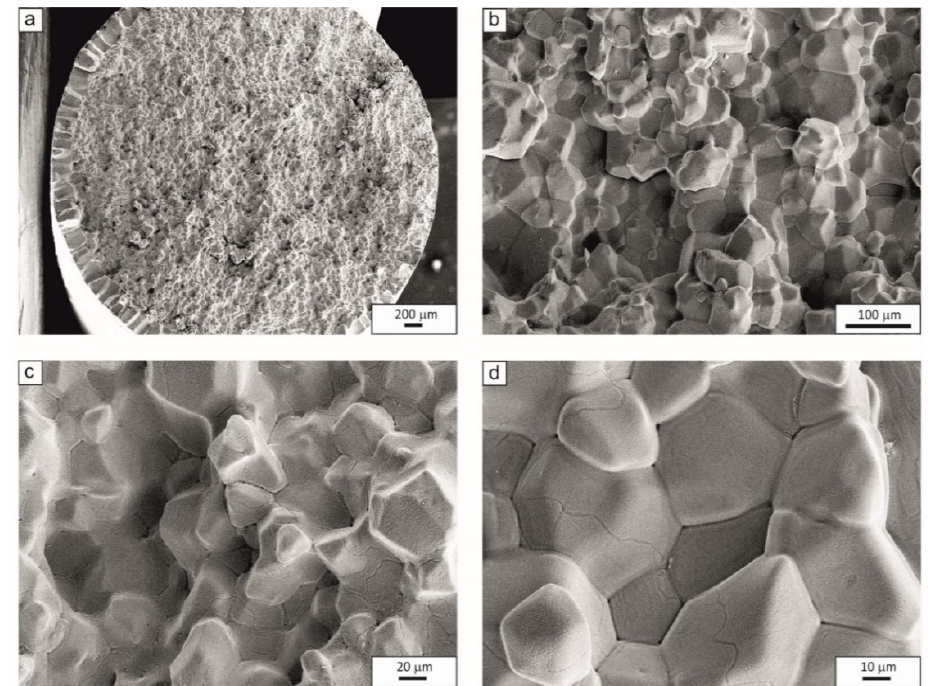
Figure 7. Fracture surfaces of samples of 24Mn-3Si-1.5Al-Nb-Ti steel after cracking at NST 2 = 1269 °C. ( a ) brittle fracture, ( b ) intercrystalline fracture area, ( c , d ) melted grain boundaries.